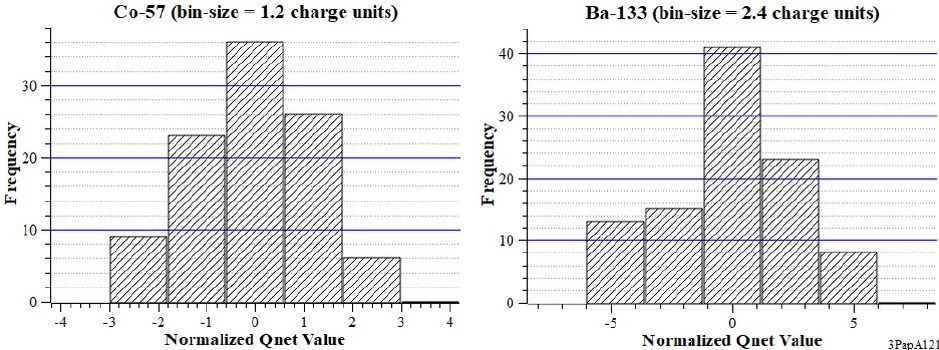
Figure A5. Histograms of average Qnet crystal-pixel values from Co-57 ( left ) or Ba-133 ( right ) data. Plots were drawn with 1.2- and 2.4-mm bins, respectively.